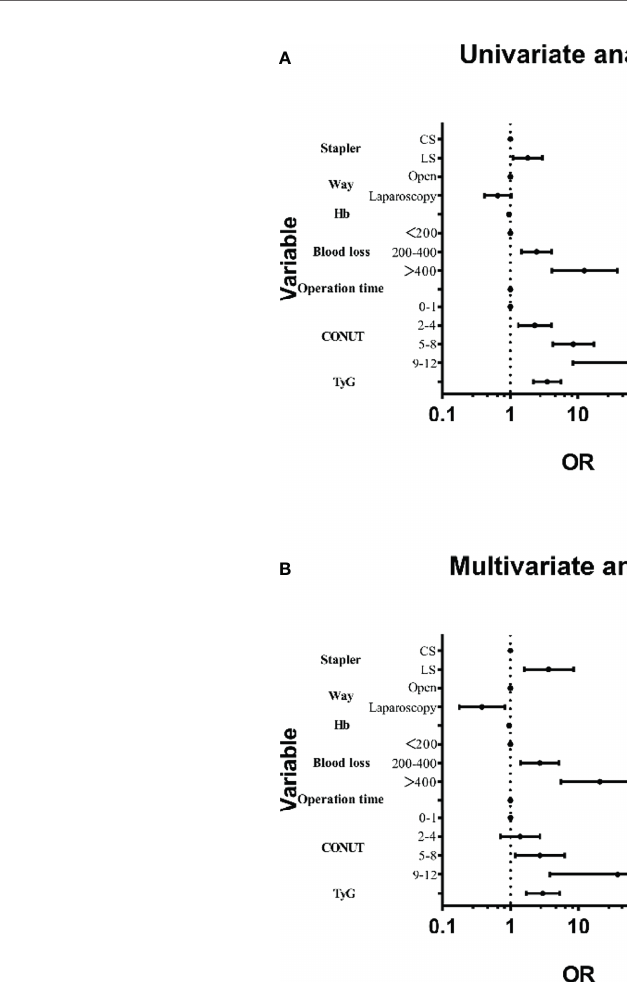
FIGURE 2 | (A) Results of univariate analysis. (B) Results of multivariate